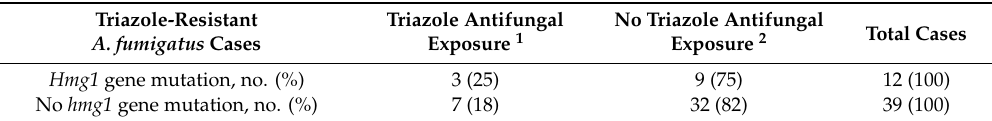
Table 1. Exposure to Triazole Antifungals in Patients with Triazole-Resistant Aspergillus fumigatus Isolates According to hmg1 Gene